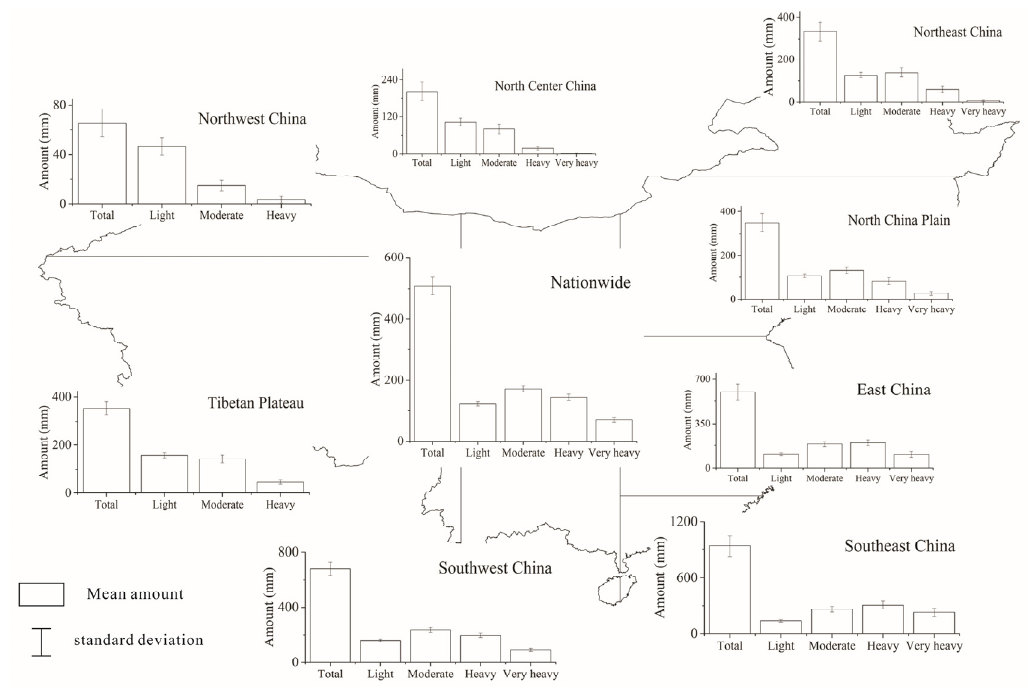
Figure 2. Distribution of long-term (1960–2018) mean amount of rain-season precipitation with different grades.